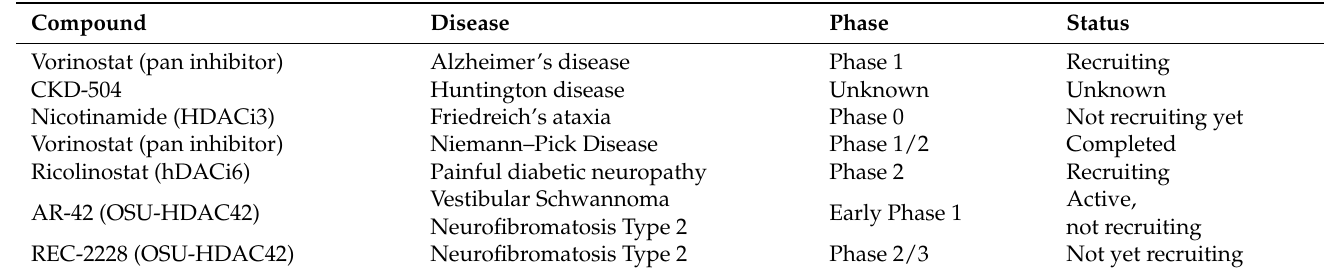
Table 3. Examples of HDACs inhibitors in clinical trials of diseases of CNS and PNS (from https: //clinicaltrials.gov/) (Accessed on 18 February